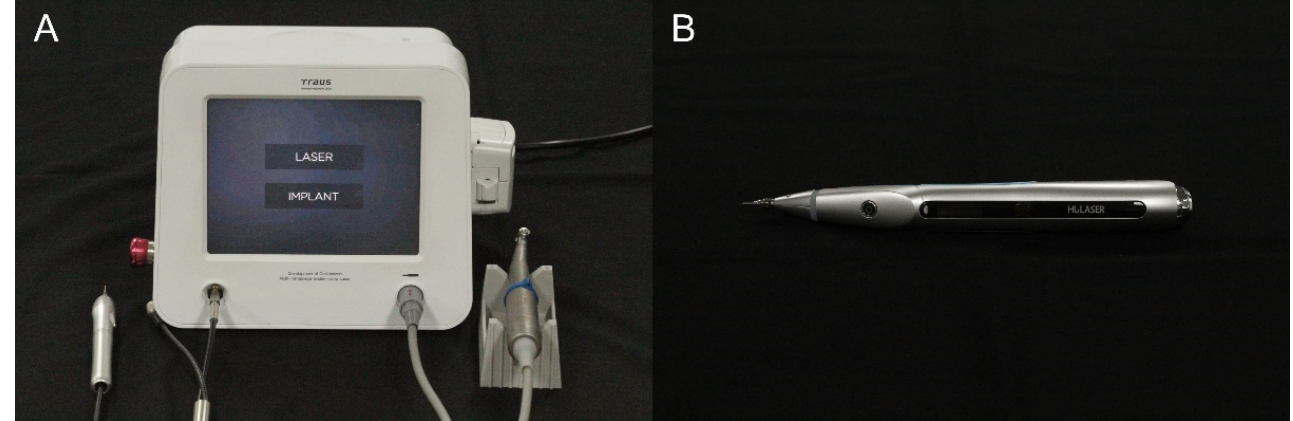
Figure 1. Dental diode laser device used in the present study. ( A ) Laser A group. ( B ) Laser B group.